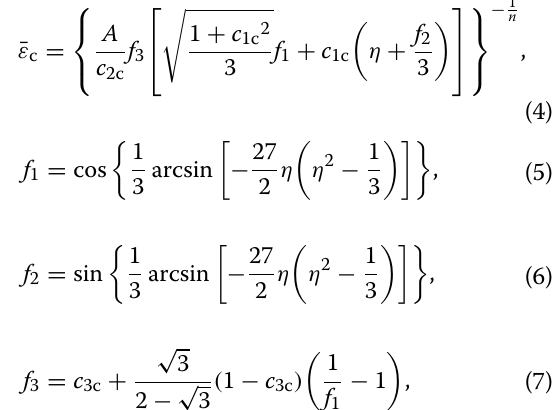
ε c (η) is the critical equivalent strain related to the where ¯ stress triaxiality η , σ m is the mean stress. The relationship between the critical equivalent strain and the stress triaxiality represented by the MMC crite- rion is defined as follows [5,